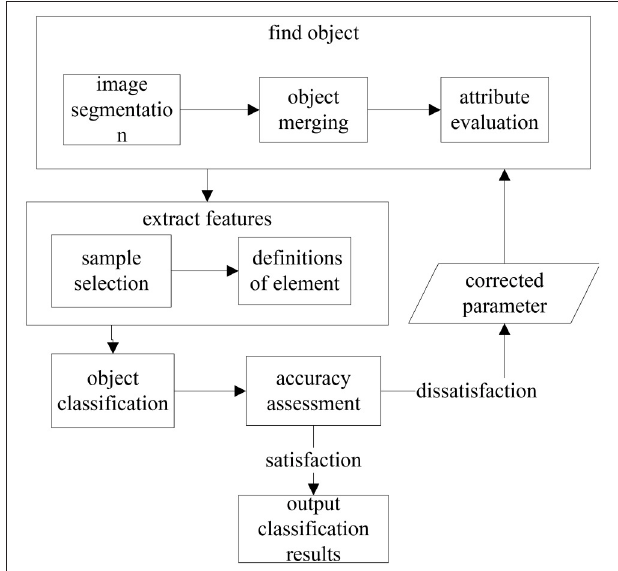
FIGURE 2 | Object-oriented classification